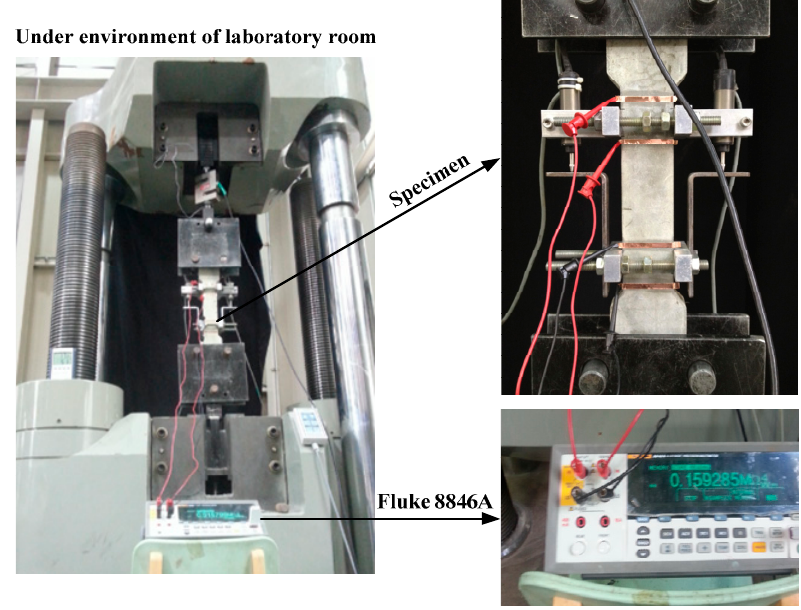
Figure 6. Electro-tensile test setup.